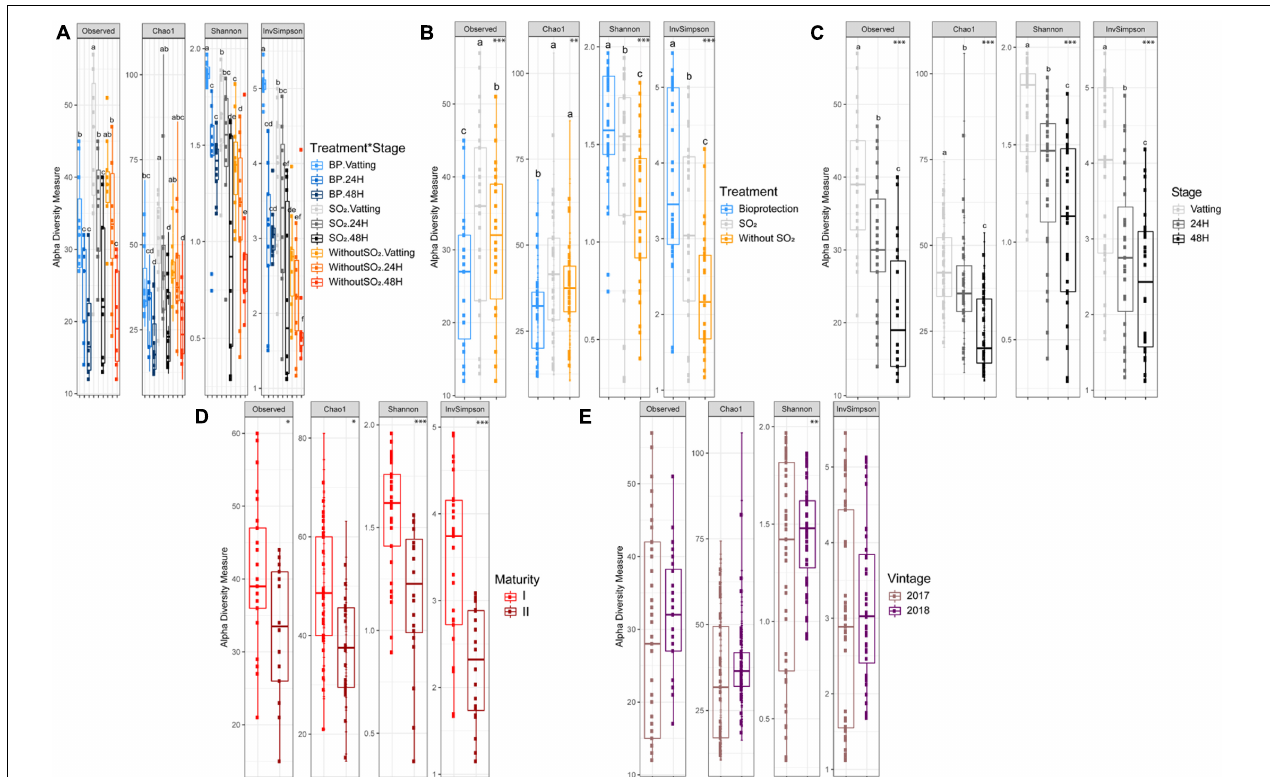
FIGURE 4 | α – diversity by four indices (Observed, Chao1, Shannon, InvSimpson) according to Treatment ∗ Stage (A) , Treatment (B) (Bioprotection (BP), SO 2 and Without SO 2 ), Stage (C) (Vatting, 24H and 48H of maceration), Maturity (D) [technological (I) and advanced maturities (II)] and Vintage (E) (2017 and 2018). Significance is indicated as follows: * significant at 5%, ** significant at 1%, *** significant at 0.1% (ANOVA and T-test), and boxplot with different letters differ significantly